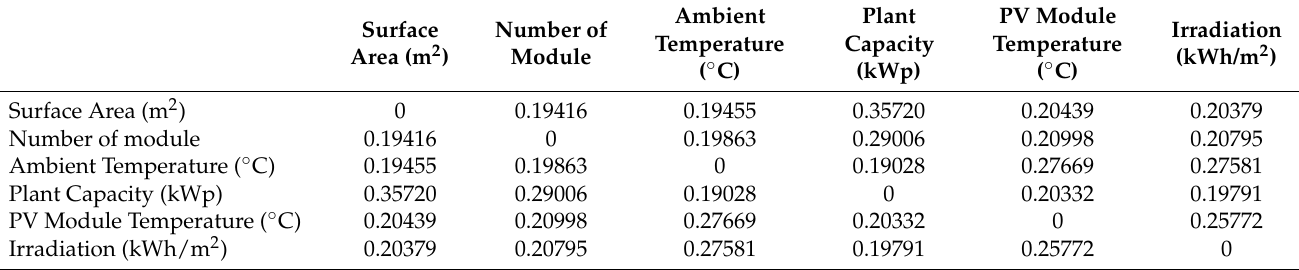
Table 5. Diversity Matrix.